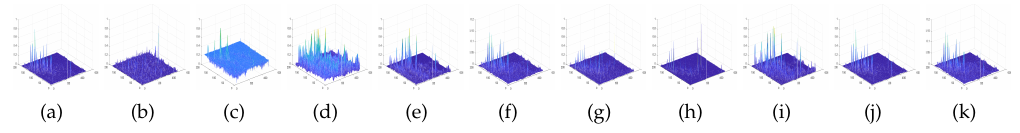
Figure 22. Three-dimensional plots of detection results for the Target Detection Blind Test dataset. ( a ) GRX; ( b ) BJSRD; ( c ) LSAD; ( d ) LRASR; ( e ) LSMAD; ( f ) CBAD; ( g ) CRD; ( h ) LRX; ( i ) LKRX; ( j ) OSP; and ( k ) BDSLRR.